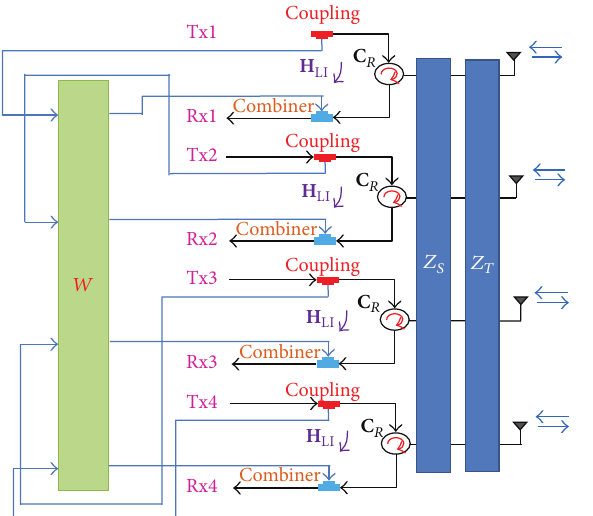
Figure 7: Proposed self-interference cancellation for full-duplex single-channel 4 × 4 MIMO system based on mutual-coupling model.